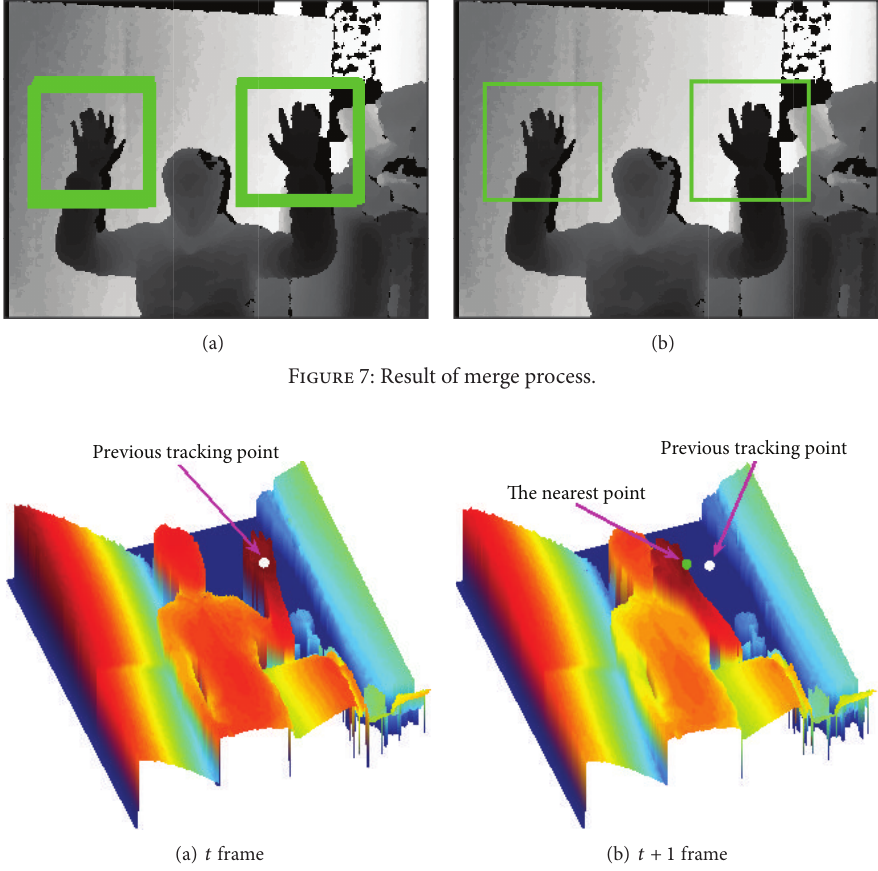
Figure 8: Transition of tracking